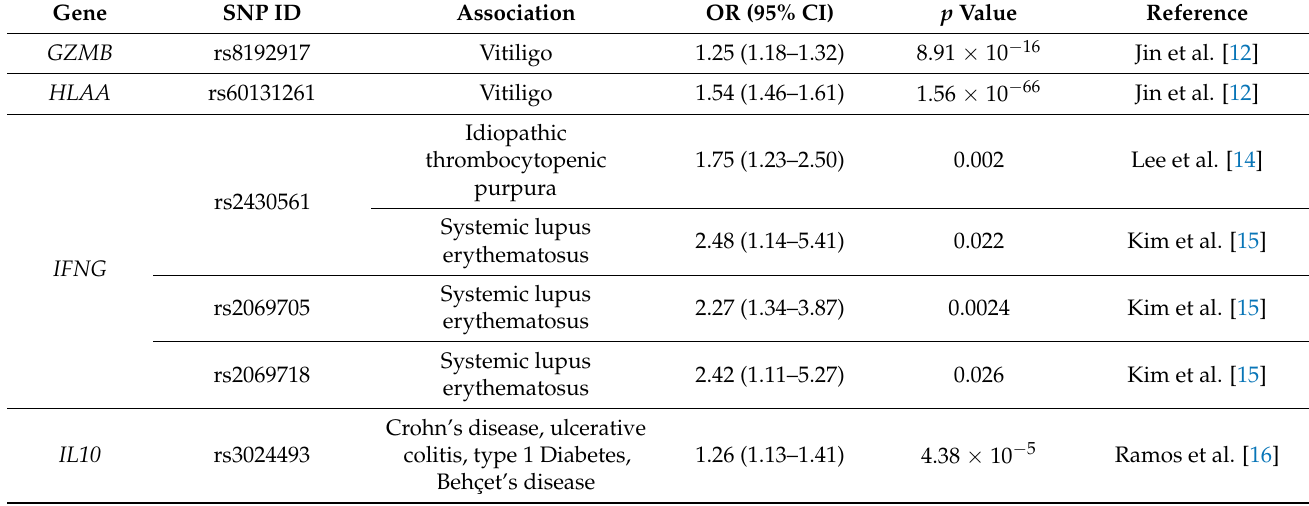
Table 1. Literature overview of selected single nucleotide polymorphisms (SNPs) and their associations with autoimmunity. Gene SNP